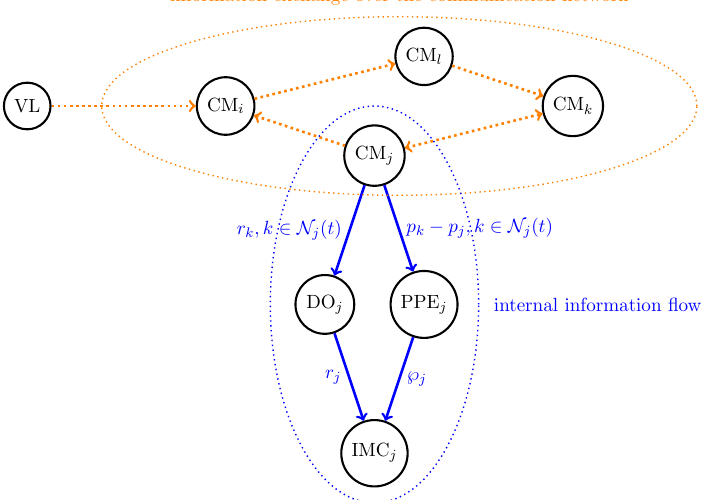
Figure 1. Information flow among different parts of the distributed robust control scheme. “VL” denotes virtual leader. “ CM j ”, “ DO j ”, “ PPE j ” and “ IMC j ” denote the communication module, dis- tributed observer, pseudo position estimator and internal model control for the j th AUV, respectively. The communication module is in charge of information exchange over the communication